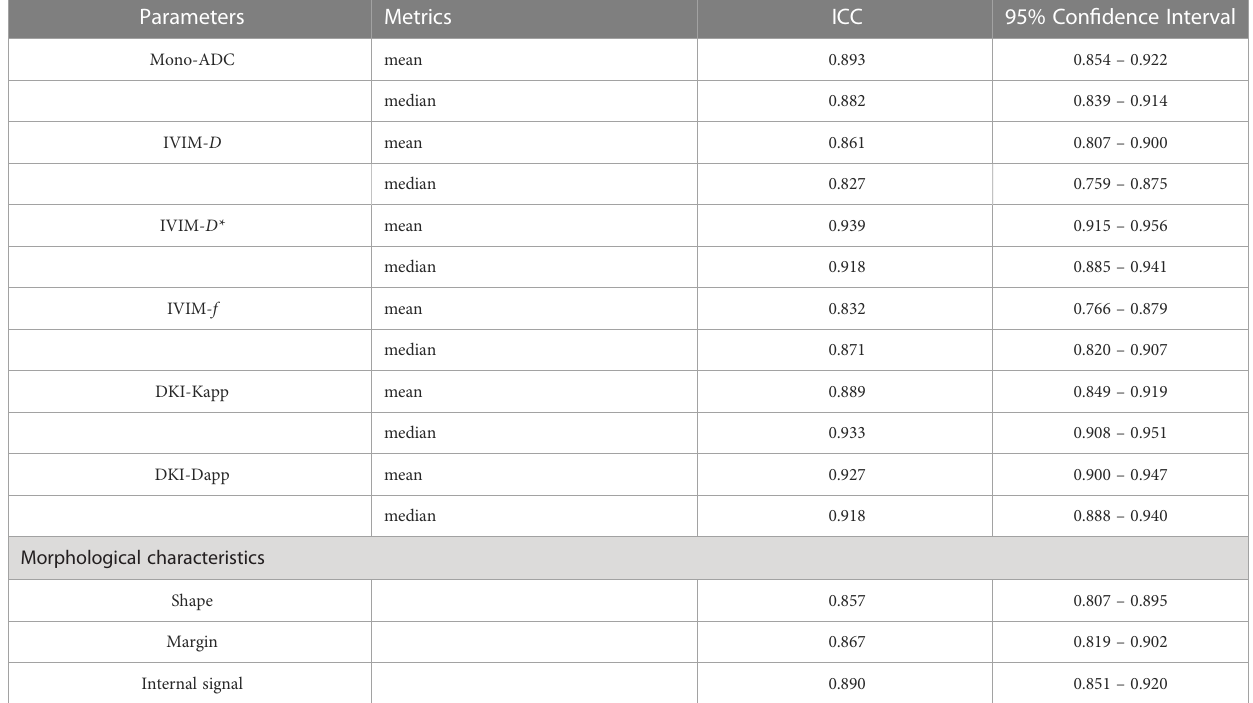
TABLE 3 Interobserver agreement for diffusion parameters and morphological characteristics by two